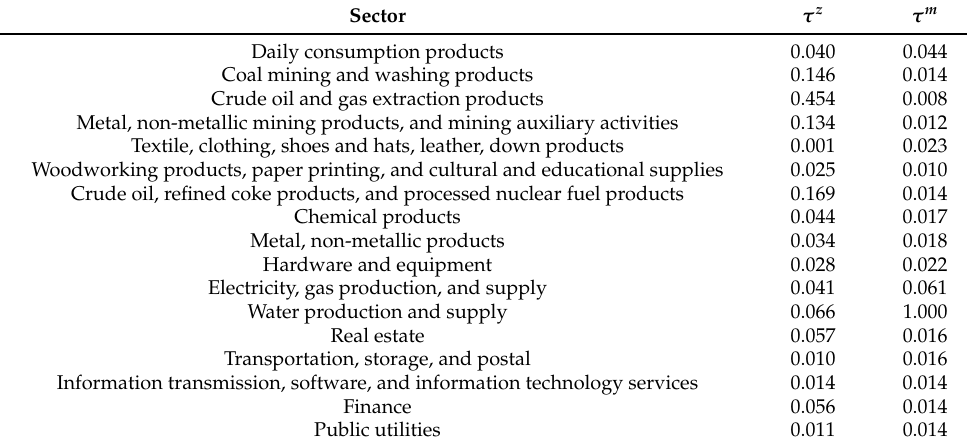
Table A10. The results of calibration of τ z and τ m .